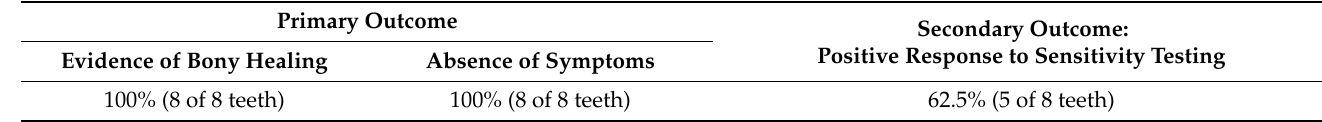
Table 8. Success rates obtained in adult permanent mature teeth performed by REP through case reports.